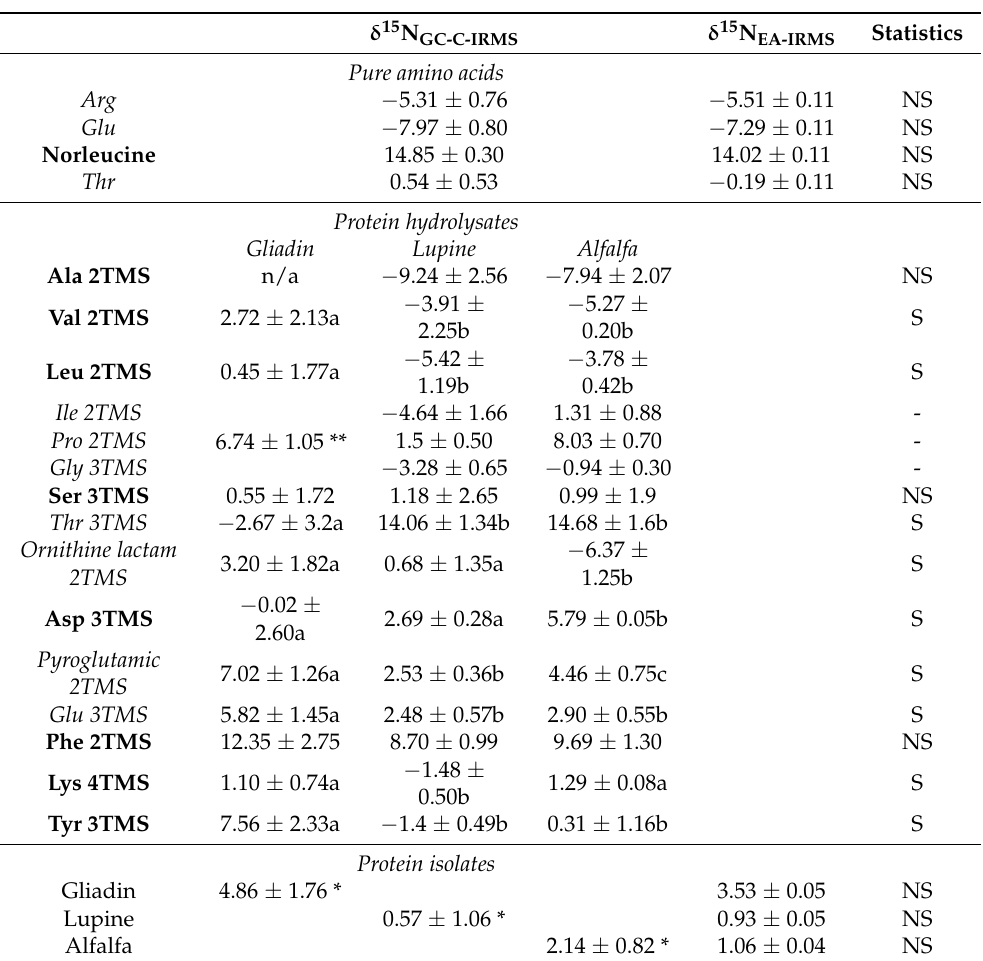
Table 1. δ 15 N values in selected amino acids, either pure standards or derivatives from protein hydrolysates . When available, the comparison with the “true” value obtained by EA-IRMS is shown. The simple asterisk (*) indicates calculated values (weighted average, i.e., δ 15 N values weighted by relative mass-28 signal). The double asterisk (**) shows a common value for Ile, Pro and Gly derivatives in gliadin hydrolysates since it was difficult to do separate signal integrations to compute individual δ 15 N values. This table only shows δ 15 N values for amino acid derivatives with a sufficient signal to allow reliable determination (typically signal intensity >0.4 nA for mass-28; under this value, there is a significant loss in linearity). Results of statistical analyses (one-way ANOVA) are provided on the right-hand side, testing differences between GC-C-IRMS and EA-IRMS (pure amino acids), between species (protein hydrolysates) and between weighted average and EA-IRMS (protein isolates). Statistical classes are shown with lower case letters. NS, insignificant; S, significant ( p < 0.05). Amino acids associated with potential methodological issues discussed in text (Sections 2 and 3) are shown in italics , while others appear in bold